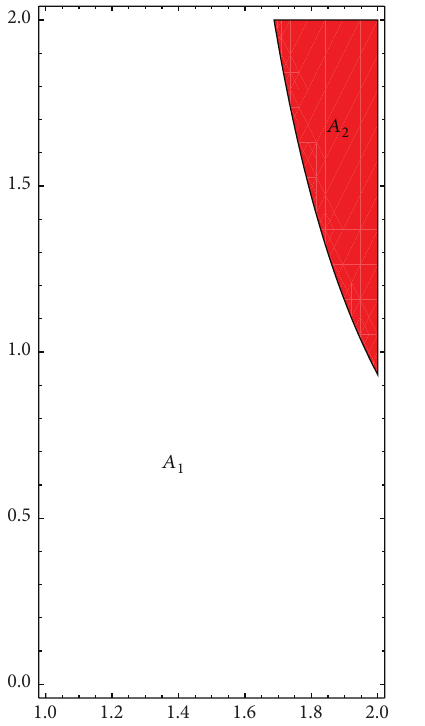
Figure 18: Number of fixed points of the composition 𝑓 𝛼 ∘ 𝑔 𝛽 . In 𝐴 𝐴 1 there is one fixed point; in 2 there are three fixed points. When (𝛼,𝛽) = (2,2) there are four fixed points.